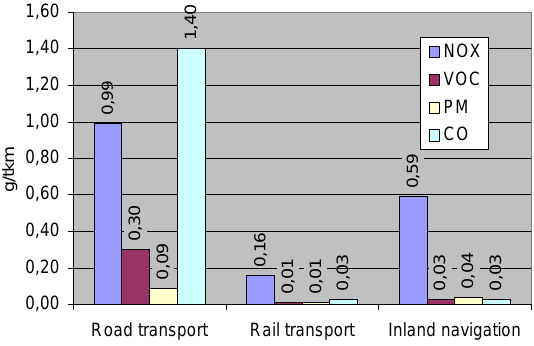
Fig 10. Specific CO 2 emissions by mode, in EU-15, in 2000, data from [21] Fig 11. Specific emissions of air pollutants by mode, in EU-15, in 2000, data from